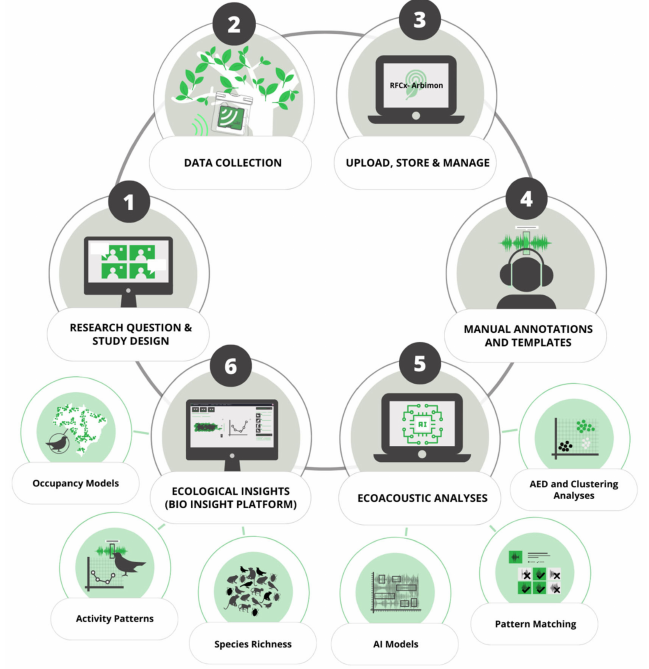
Figure 1. Infographic representing the main steps of an end-to-end pipeline for large-scale passive acoustic monitoring (PAM). Step 1—The project begins with study design, during which